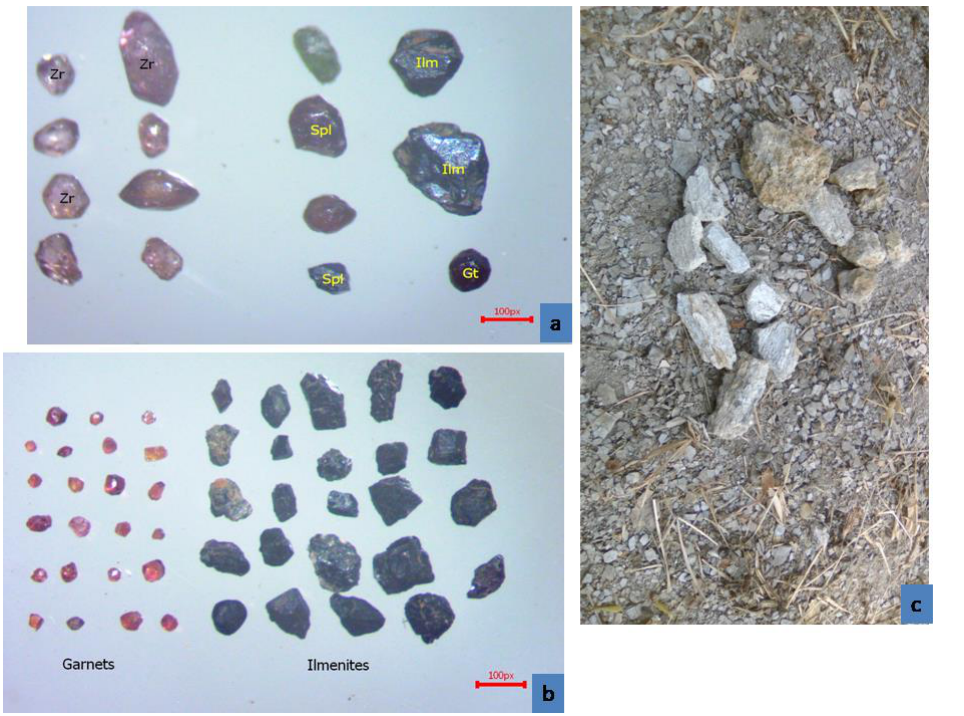
Figure 8: a Zircon, spinel and illmenite identified in the stream sediments within the prospective zones. b.Garnet and illmenite identified in the stream sediments within the prospective zones.c. Calcrete identified in the prospective